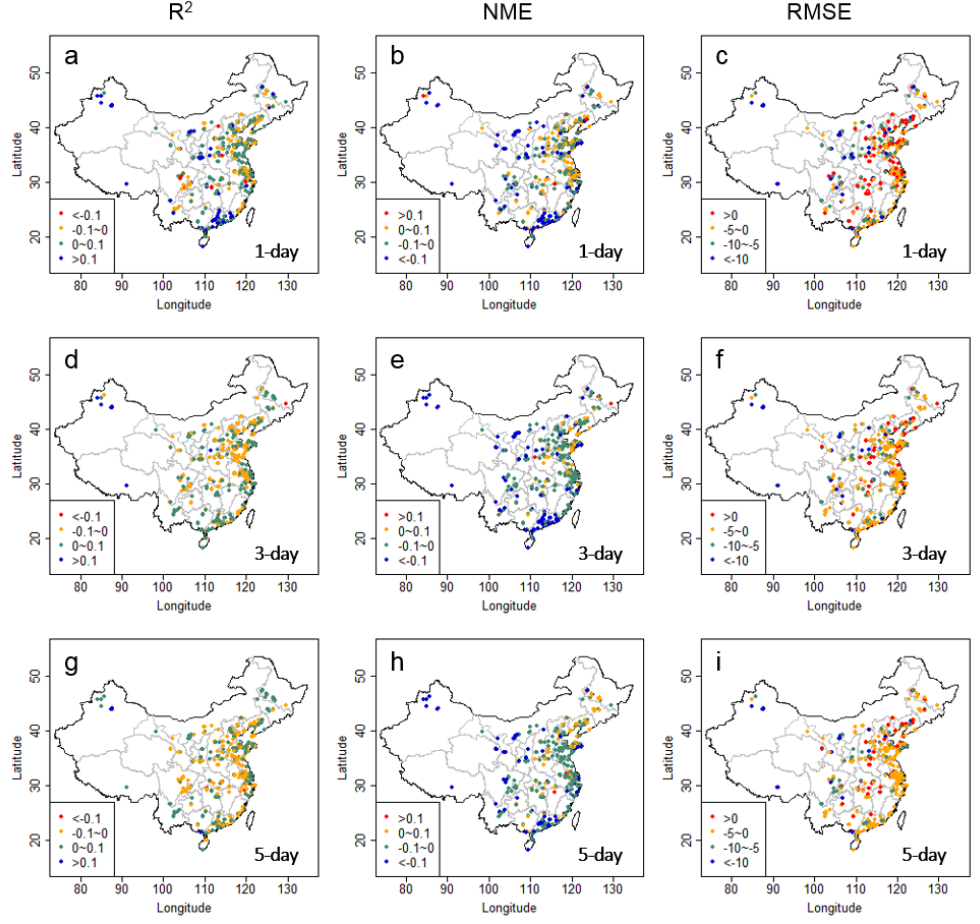
Figure 8. The difference in R 2 ( a,d,g ), NME ( b,e,h ), and RMSE ( c,f,i ) values between bias-corrected forecasts by the CART-LM-KF-AN method and raw CMAQ forecasts (Corrected forecast minus raw forecasts) at the 545 avg-monitors for the 1, 3, and 5-day lead times. The differences in RMSE is in µg/m 3 .